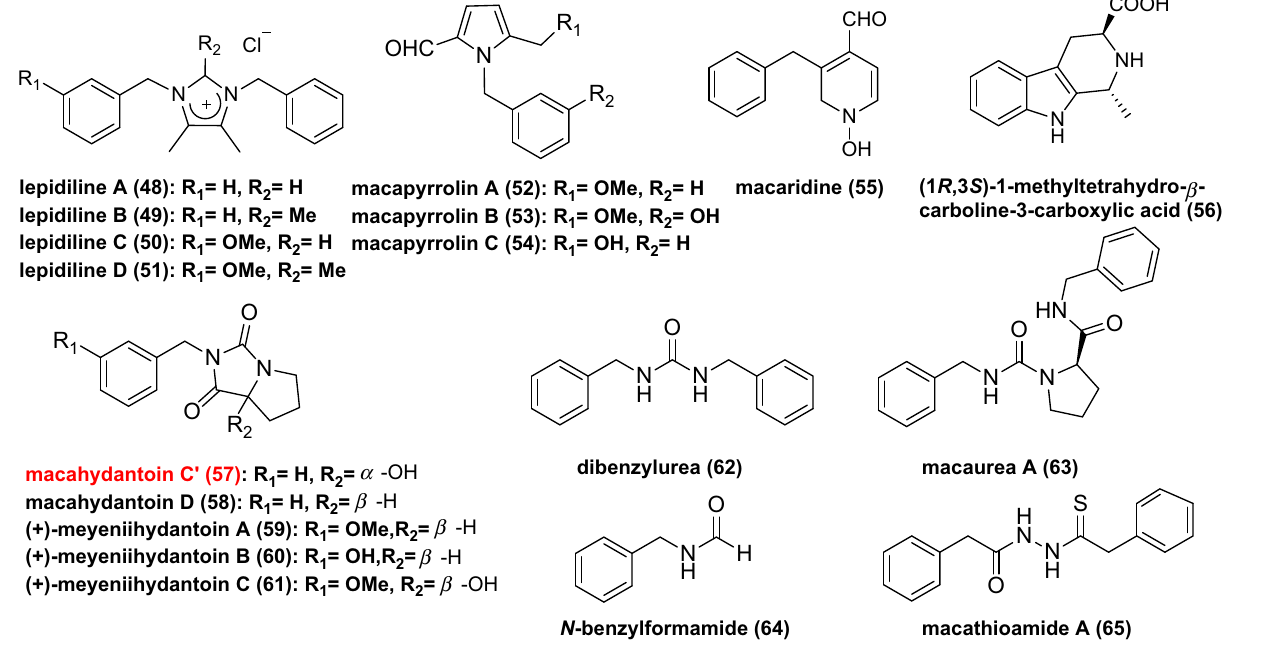
Fig. 4 Structures of alkaloids found in